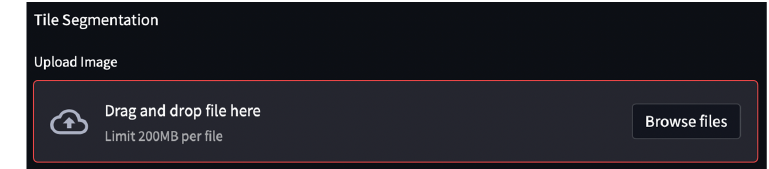
Figure 11. Image upload box.